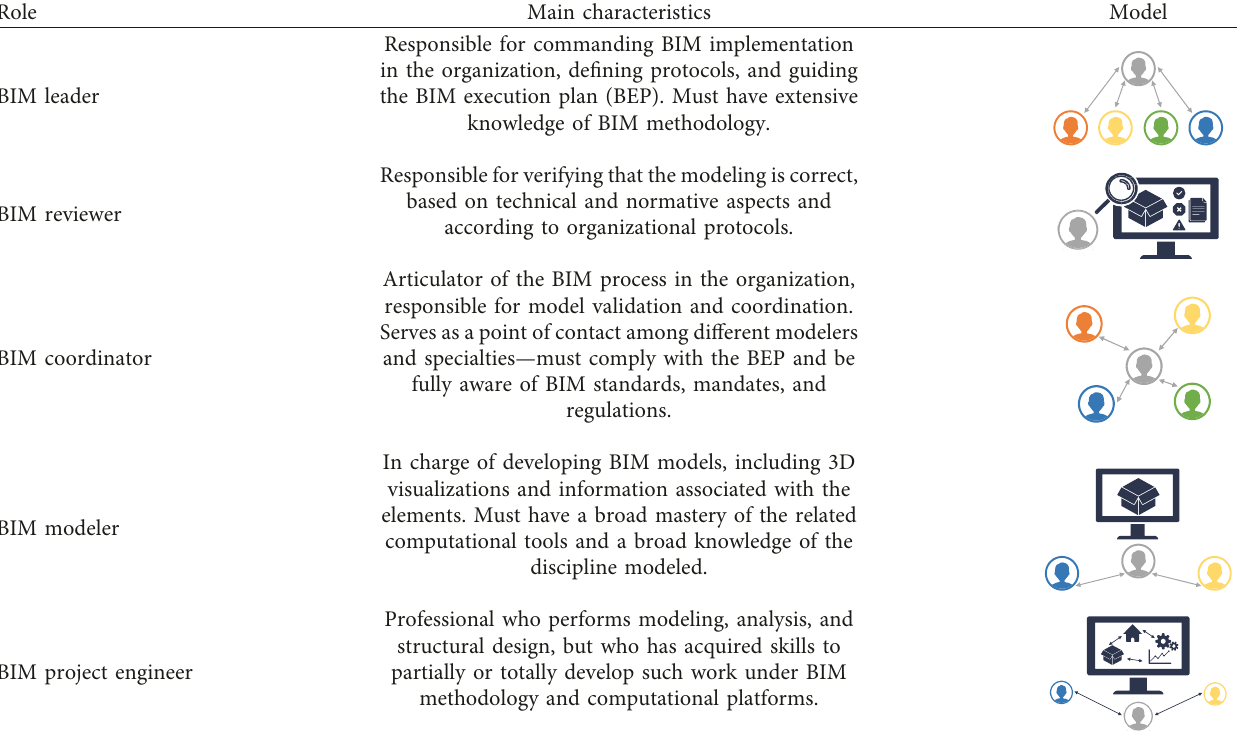
Table 3: Characteristics of BIM roles.